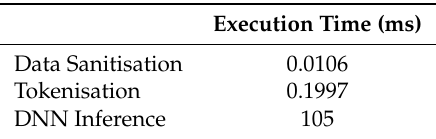
Table 5. Execution time in the